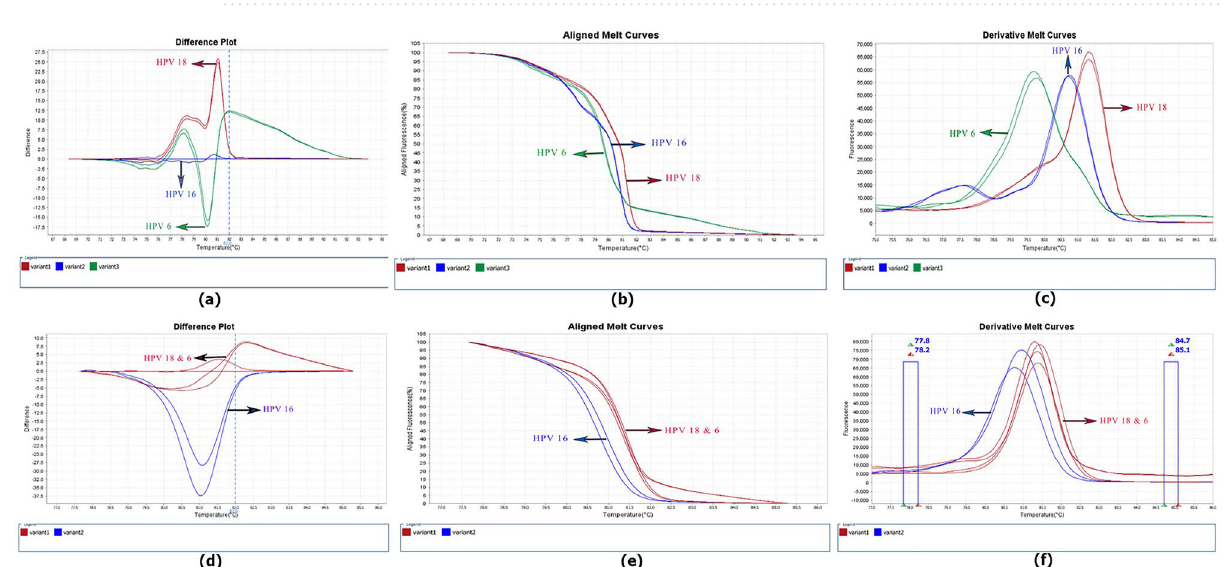
Figure 6. Difference plot, Aligned melt curves, and Derivative melt curve of semi-nested-qPCR-HRM HPV reaction for discrimination of human papillomaviruses with FRG5, FRG2, and GP5 primers in approach two ( a , b , c ). Difference plot, Aligned melt curves, and Derivative melt curve of semi-nested-qPCR-HRM reaction for discrimination of human papillomaviruses with FRG5, FRG2, and without GP5 in approach one ( d , e , f